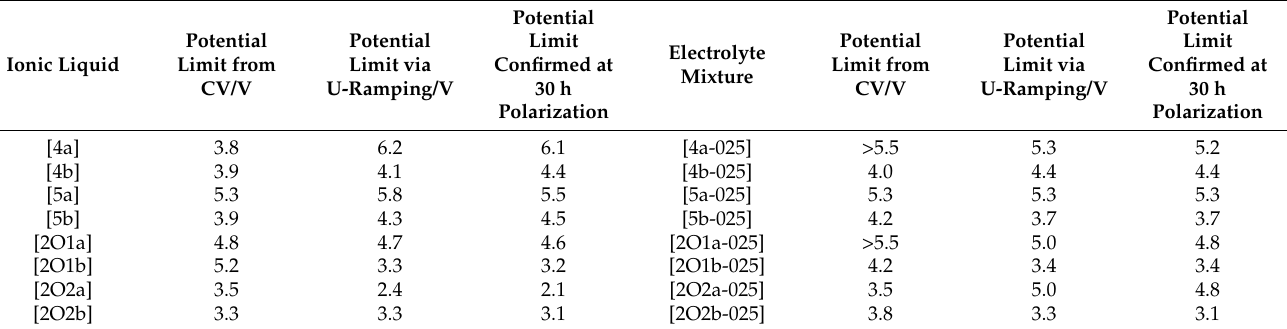
Table 7. Potential limits in Al vs. Li Swagelok-based cells which are received from (1) CV mea- surements, (2) potential step sequence measurements ( U ramping , polarization for 1 h) and (3) 30 h polarization tests with overall decreasing current density ( U max,pol , polarization for 30